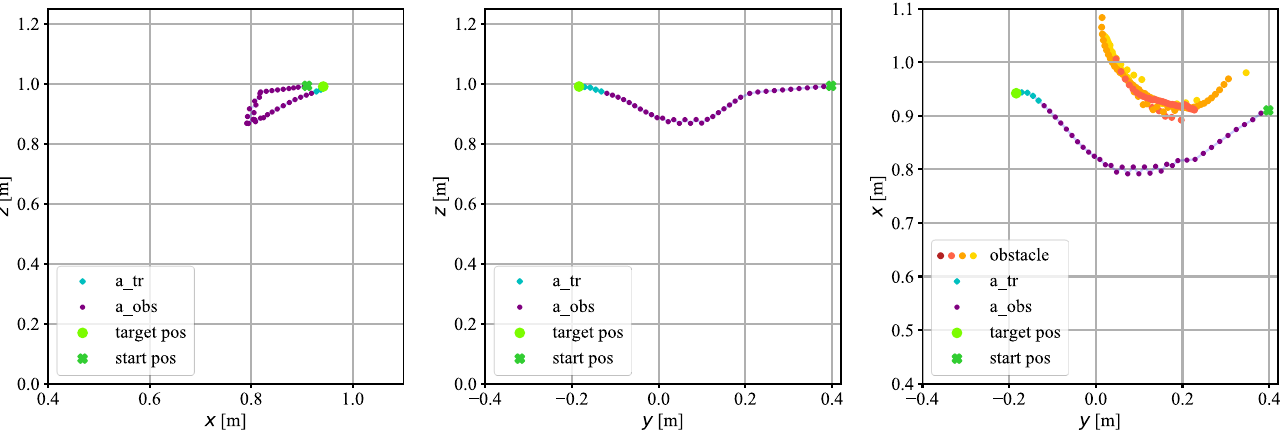
Figure 13. The trajectory on which the TCP of the robot moved in experimental research. A cylindrical obstacle. Position of the obstacle 𝑦 ≈ 0 m.